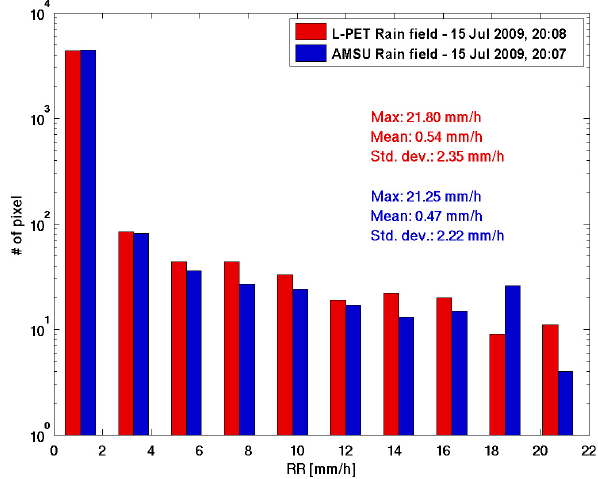
Fig. 10. Statistics of rain field provided by the AMSU-based al- gorithm applied to TB from MetOp-A satellite (blue) and rain field provided by L-PET algorithm (red), over central Europe, 15 July 2009 at